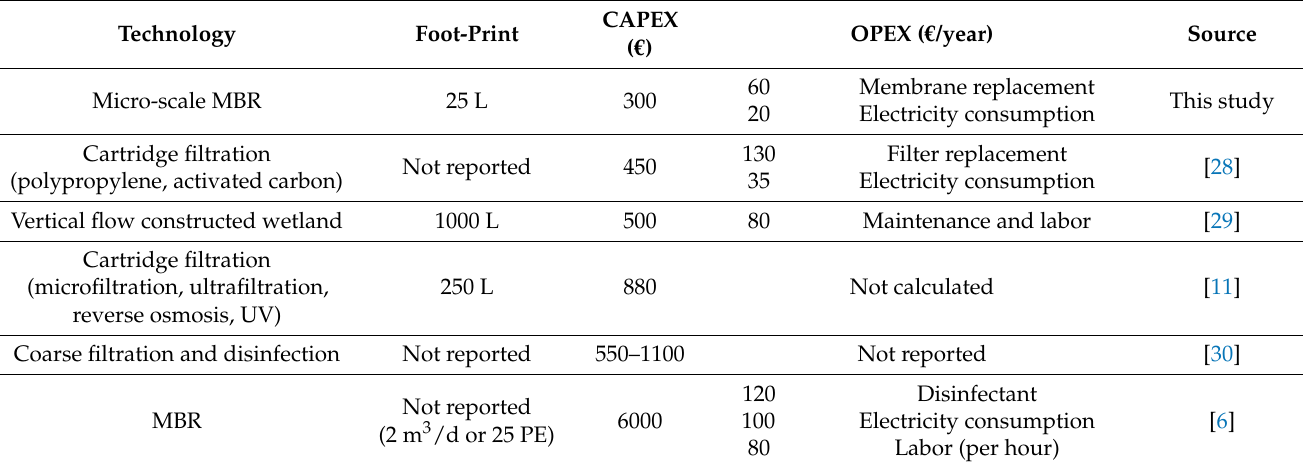
Table 2. Technical and economic comparison of household greywater treatment